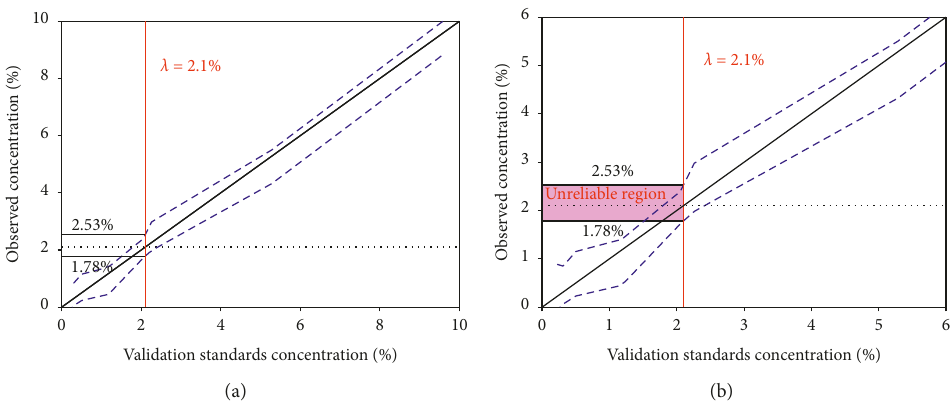
Figure 5: (a) The unreliability graph of cryptotanshinone . (b) The unreliable region estimated around the specification limit of crypto- tanshinone in tanshinone extract. Blue dashed lines are the 66.7% β -content, 90% c -confidence tolerance intervals; the diagonal continuous line is the identity line y x ; the red vertical straight line and the black horizontal dashed line are the API specification limits; the shaded (cid:31) region corresponds to the unreliable region.